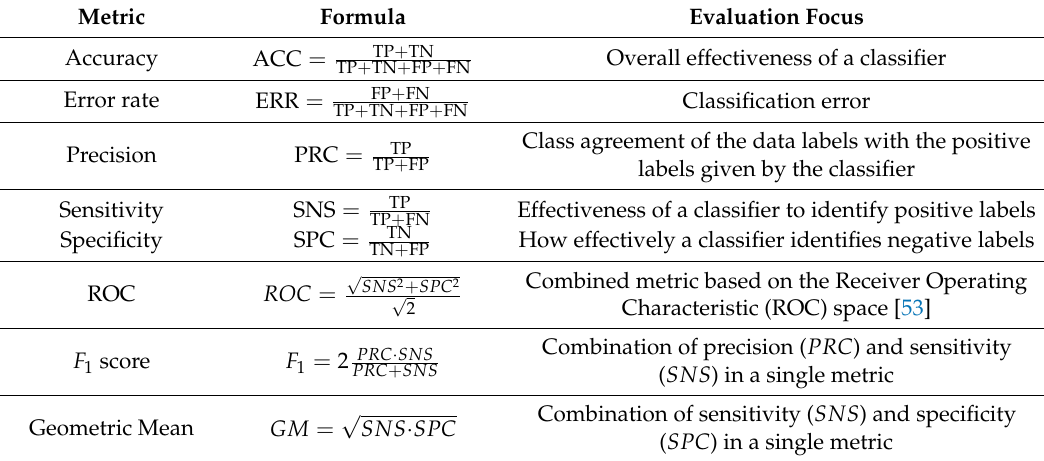
Table 4. Classification performance metrics based on the confusion matrix.